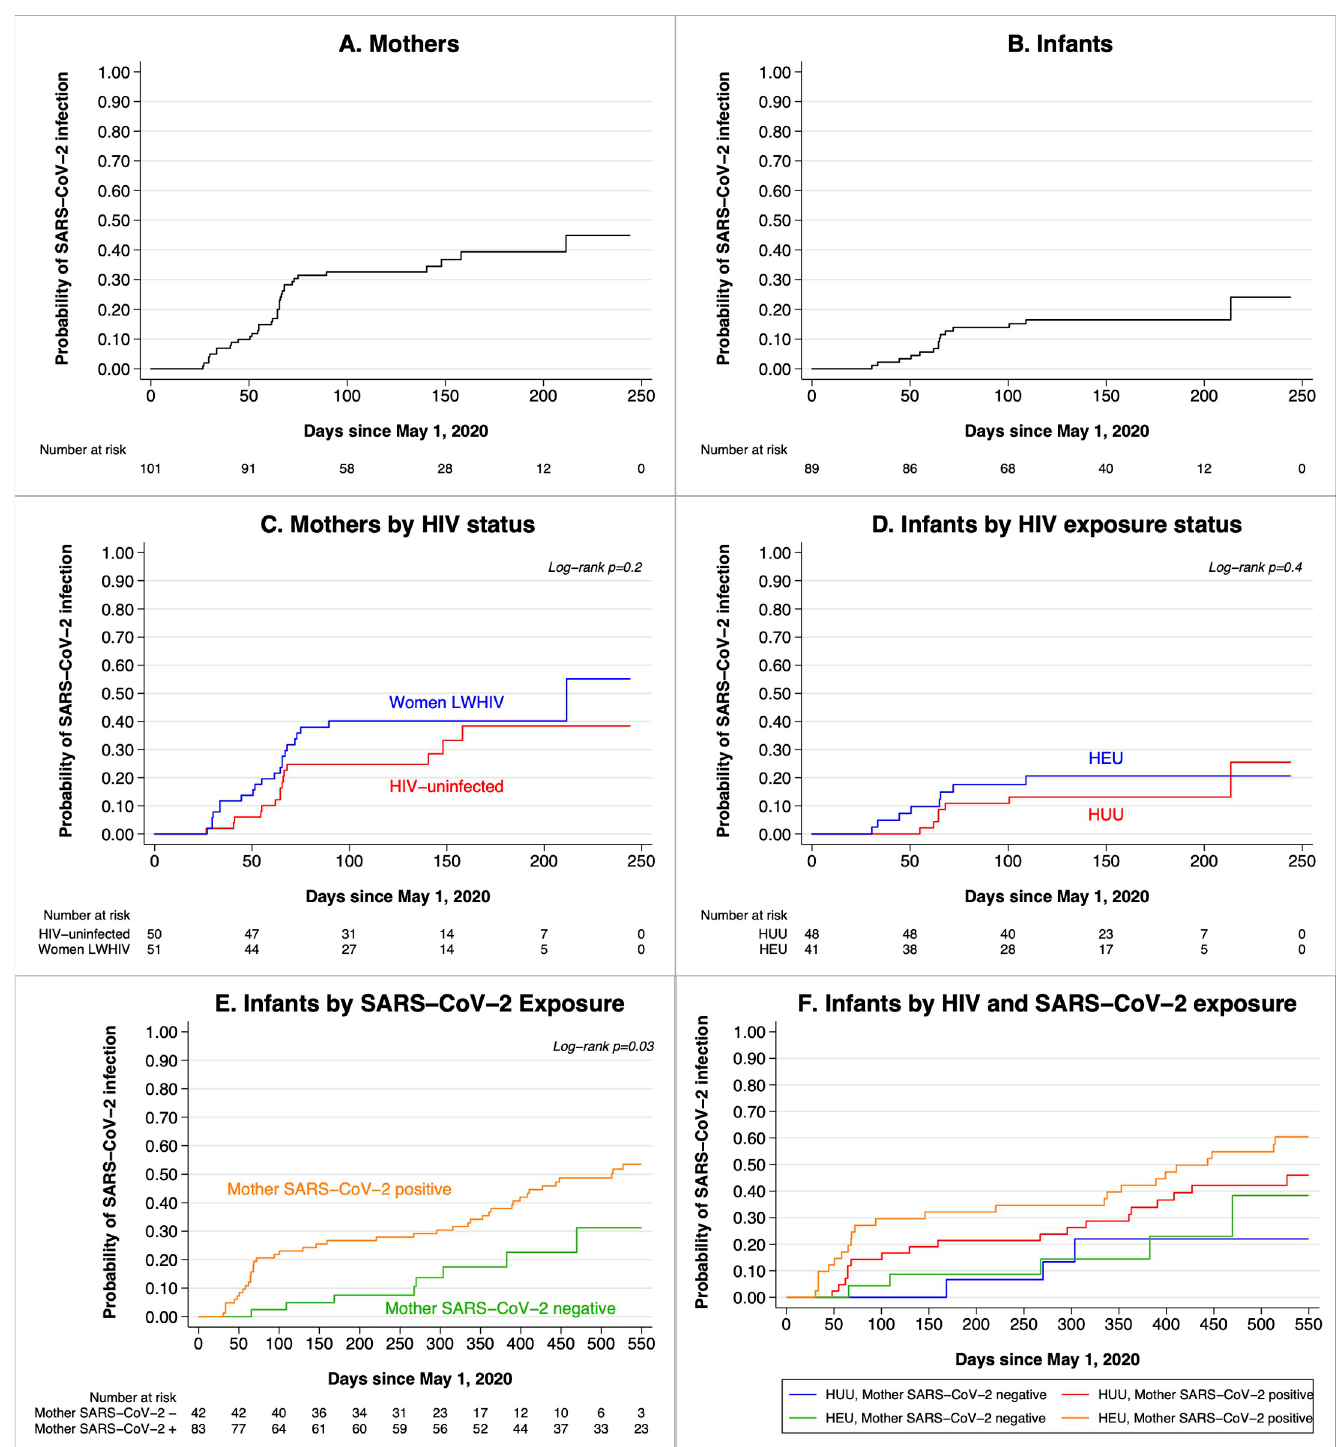
Fig 1. SARS-CoV-2 acquisition from May 1, 2020-February 1, 2022 in postpartum Kenyan women and their infants. Kaplan-Meier hazard functions for participants’ estimated date of infection are shown for (A) all mothers and (B) all infants, (C) mothers stratified by HIV status, (D) infants stratified by HIV exposure, (E) infants stratified by maternal SARS-CoV-2 infection, and (F) infants stratified by maternal HIV and SARS-CoV-2 infection. HEU = HIV-exposed uninfected, HUU = HIV-unexposed uninfected. All women enter the at-risk period on May 1, 2020; infants enter the risk period either at May 1 or on their date of birth, if after May 1. Timing of SARS-CoV-2 infection is estimated as the midpoint between the last negative and the first positive antibody test; for participants whose last negative